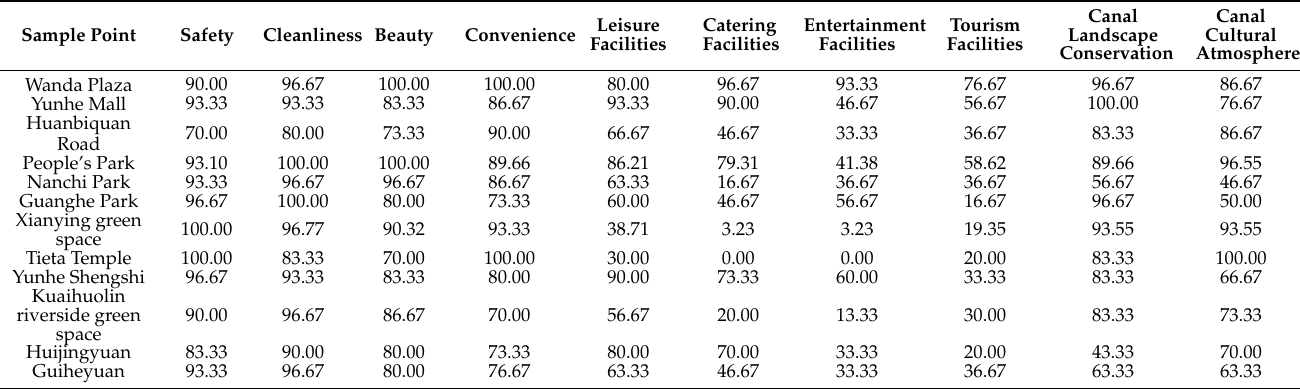
Table 3. Degree of satisfaction with various factors at 12 sample points of urban open spaces in Jining